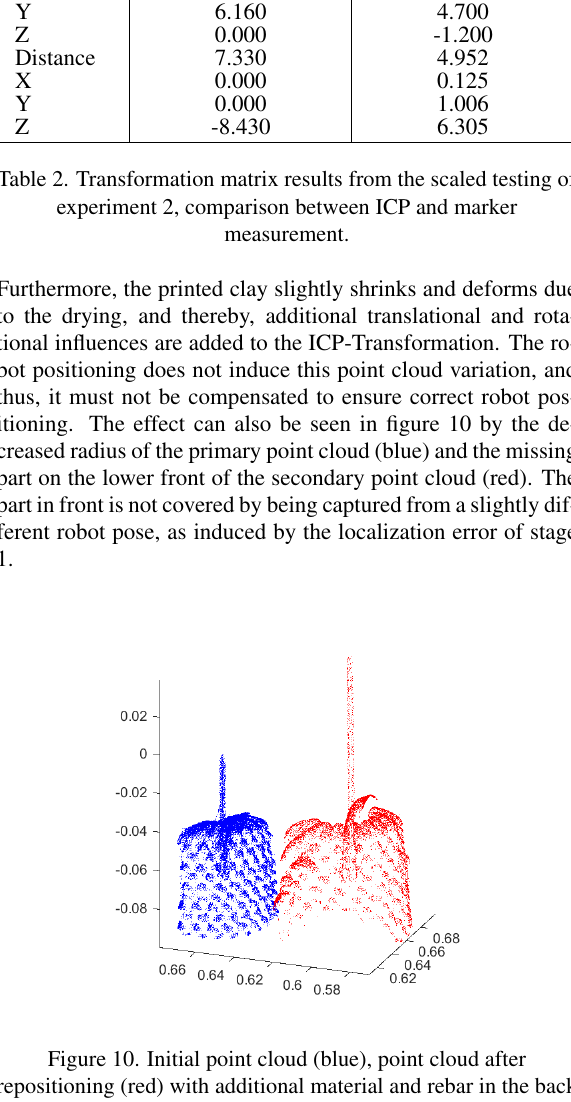
Figure 9. Initial point cloud (blue), point cloud after repositioning (red) and transformed by ICP (green)